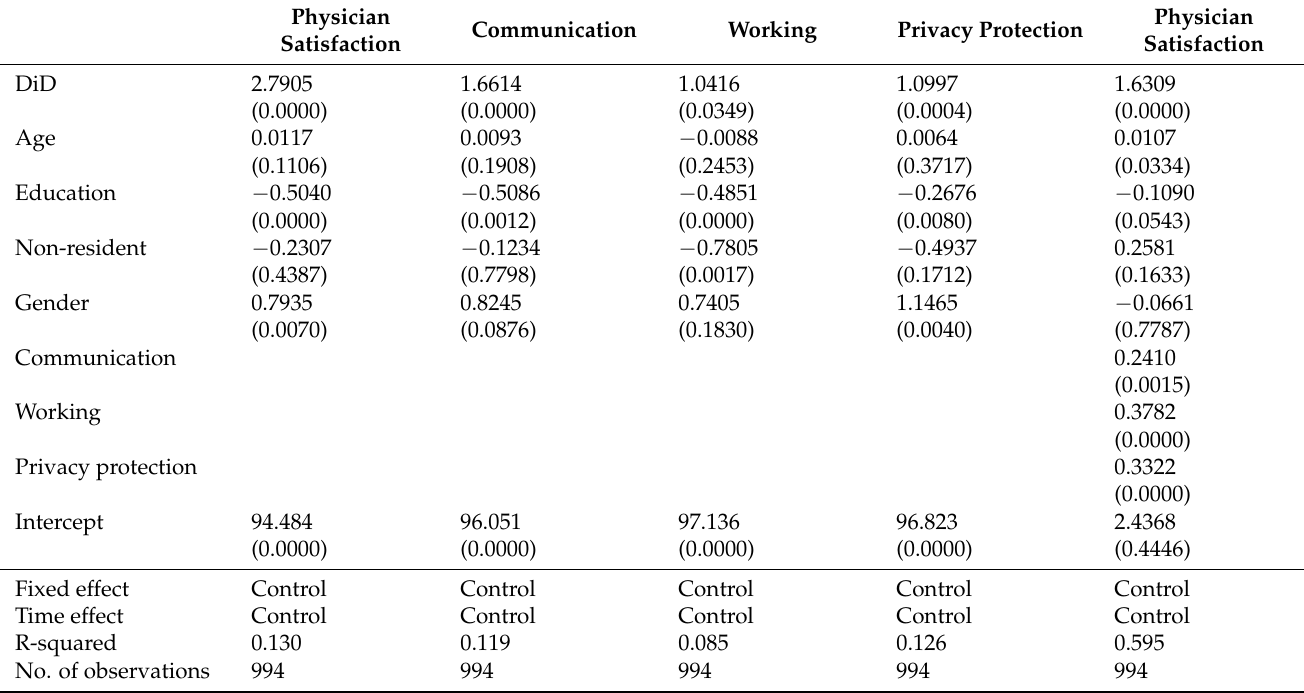
Table 3. Difference-in-difference of physician